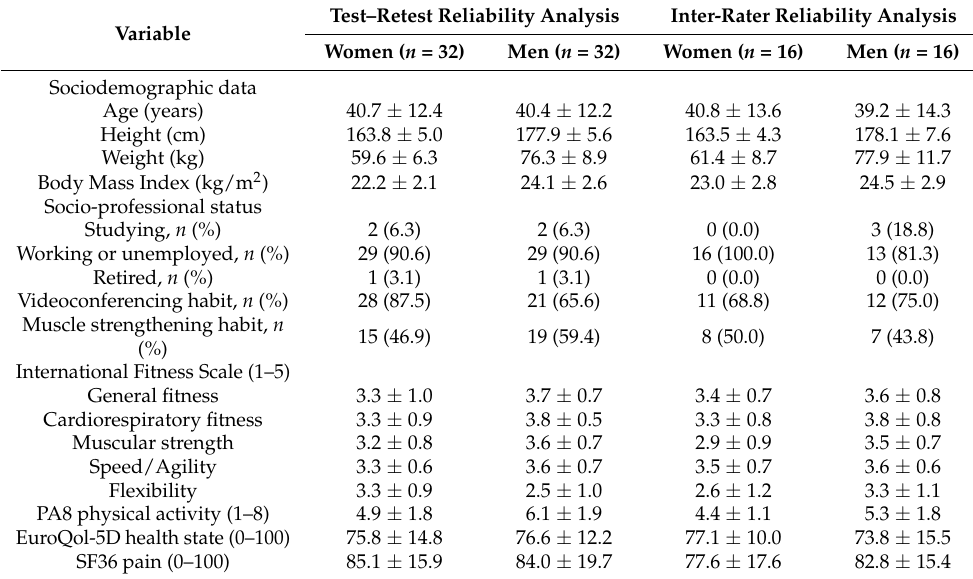
Table 1. Descriptive data of the participants.